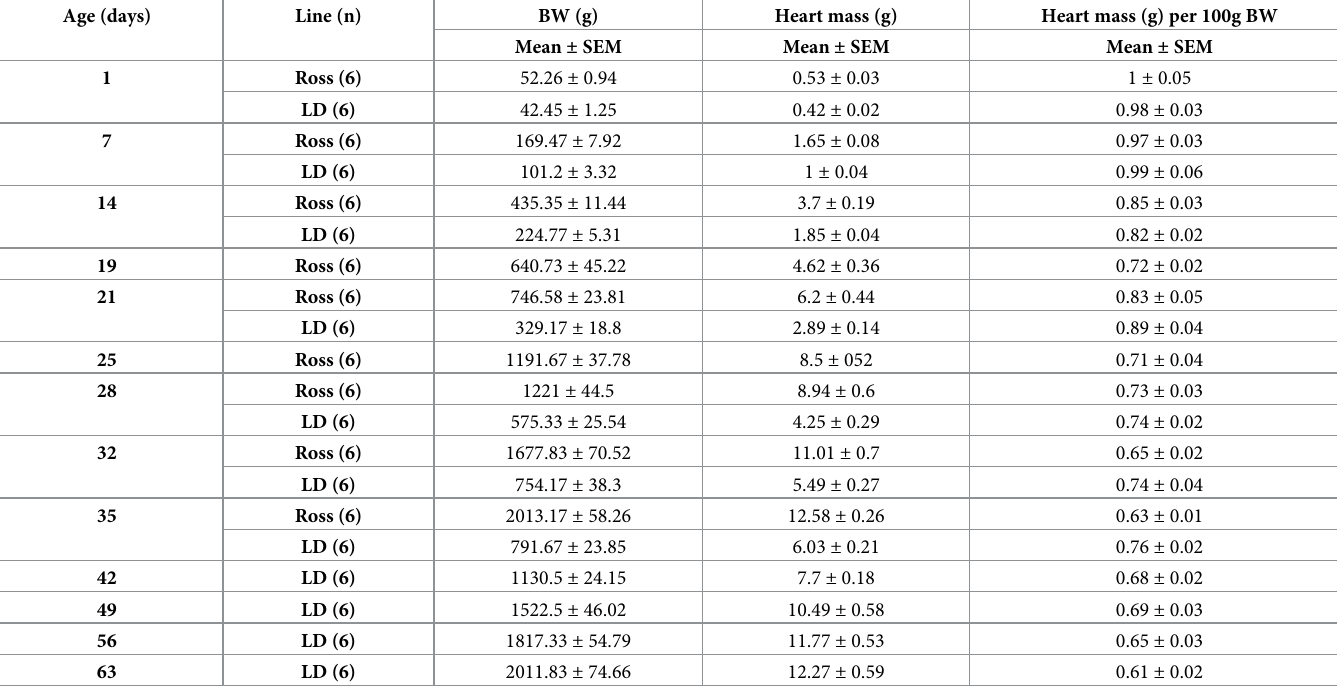
BW: live body weight; LD: Lohmann Dual; Line: genetic line; n: animal number; Ross: Ross 308; SEM: standard error of the mean.